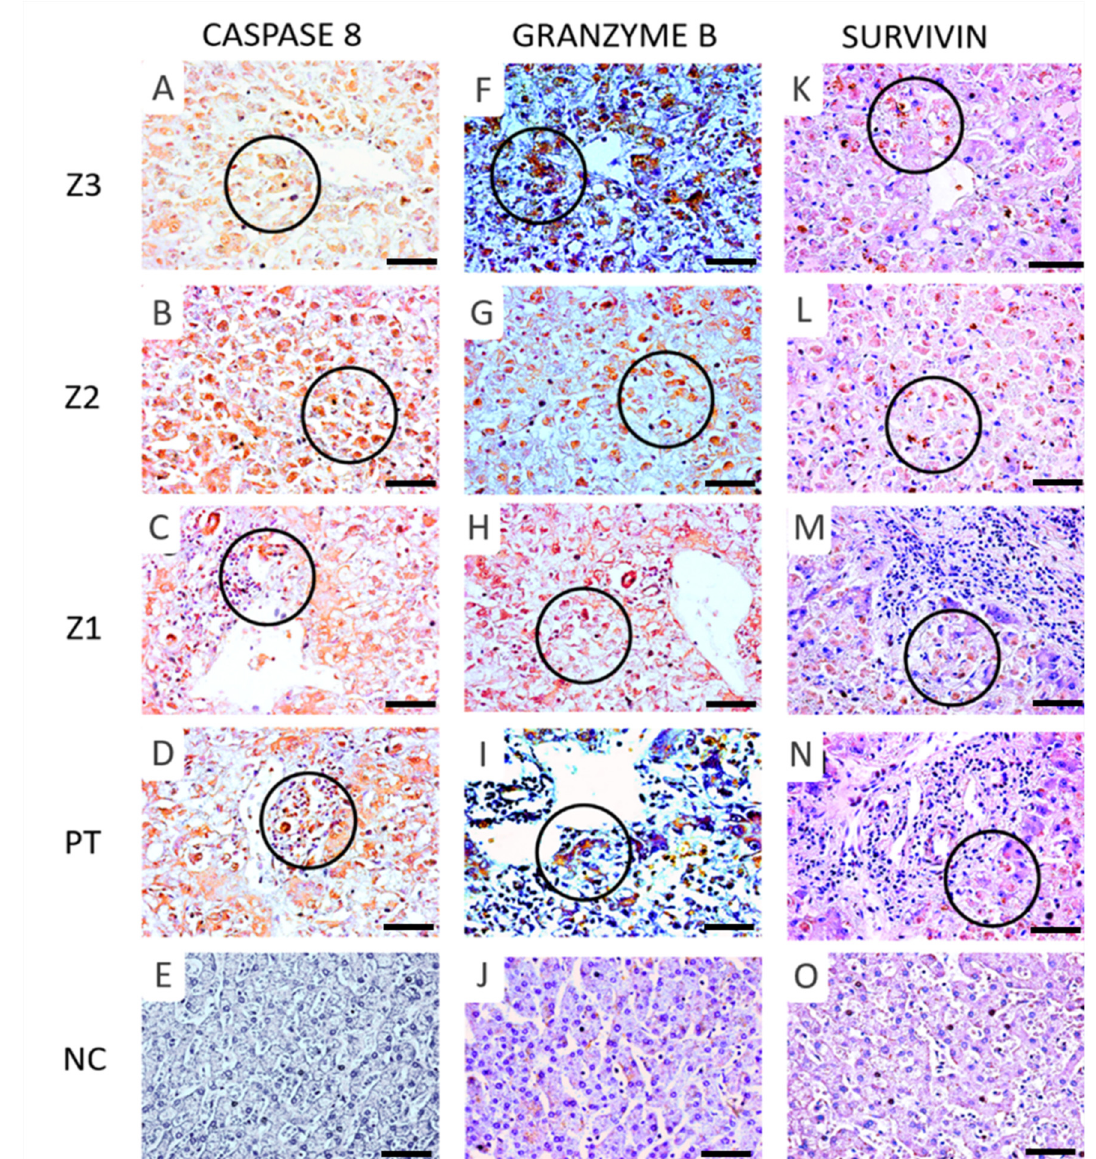
Figure 5. Immunostaining for CASPASE 8 ( A – D ) (Z3-A, Z2-B, Z1-C), GRANZYME B ( F – I ) (Z3-F, Z2-G, Z1-H), ( K – N ) SURVIVIN (Z3-K, Z2-L, Z1-M), in the hepatocytes (black circles) and D-PT, I-PT, N-PT in the inflammatory infiltrates (black circles). Preservation of hepatic parenchyma in control cases and minimal expression of CASPASE 8 ( E ), GRANZYME B ( J ), SURVIVIN ( O ). 400× magnification (scale: 20 μ m). Z3: centrolobular zone; Z2: midzonal zone; Z1: periportal zone; PT: portal tract; NC: normal control.